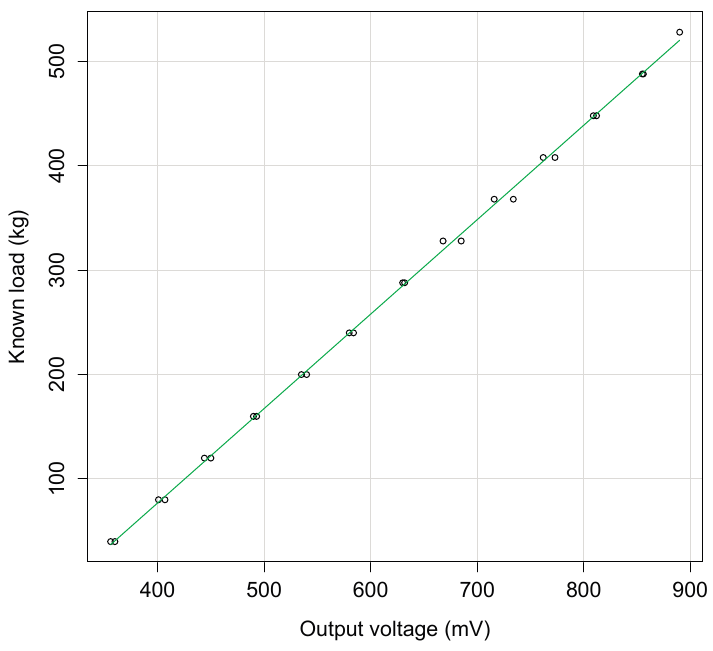
Figure 6. Relationship between the output voltage in the load cell and the known load